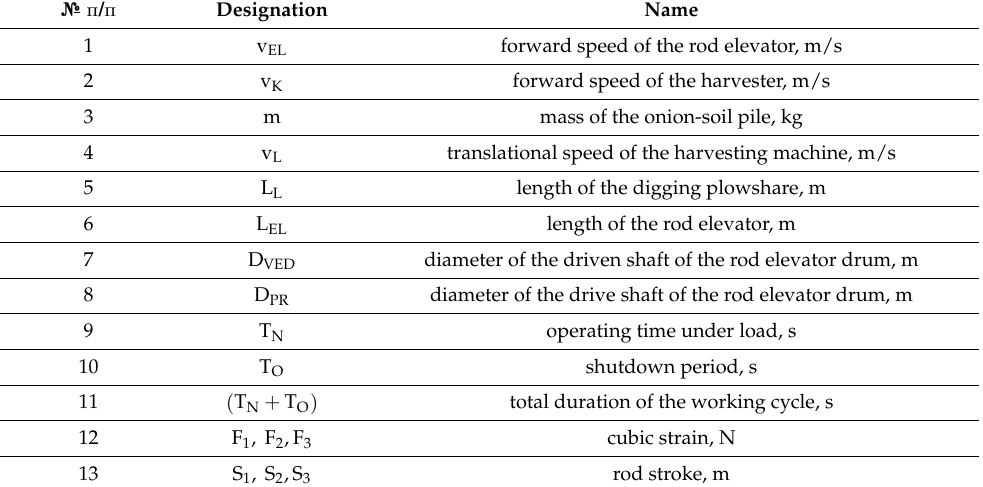
Table 1. Name of